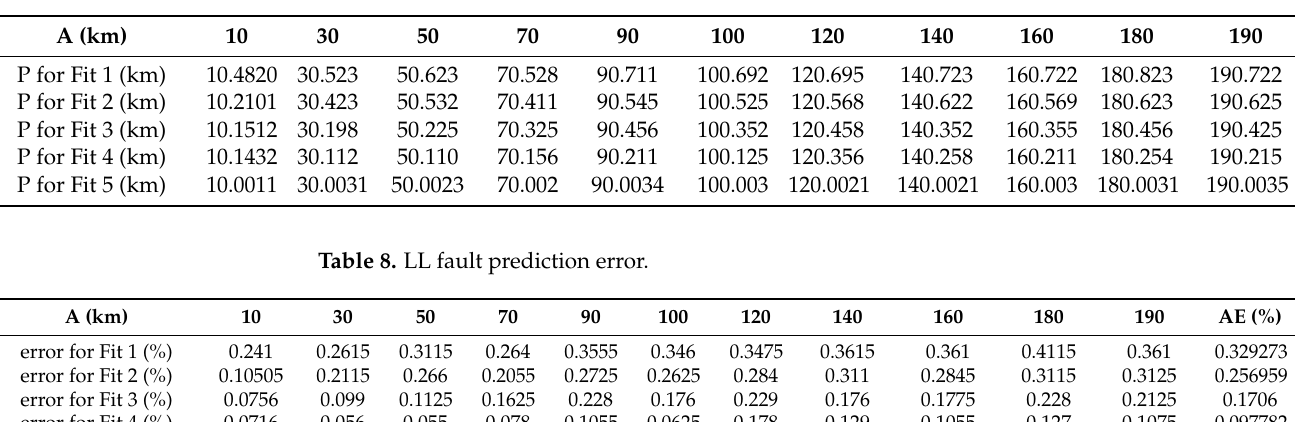
Figure 10. The best fitting curve at 19 fault locations for LLL-G fault using scaled maximum singular value. Table 7. Actual (A in km) and predicted (P in km) fault locations under LL fault scenario.